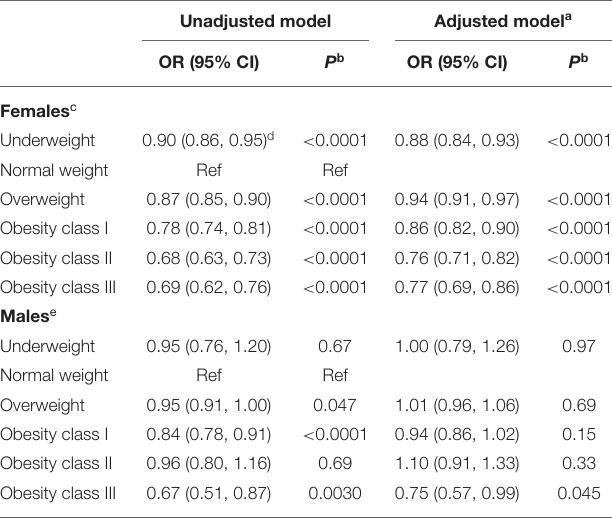
TABLE 3 | Association between mastery (PMS) and weight status (BMI categories) in n = 30,339 participants, stratified by sex (NutriNet-Santé cohort study, 2014). Unadjusted